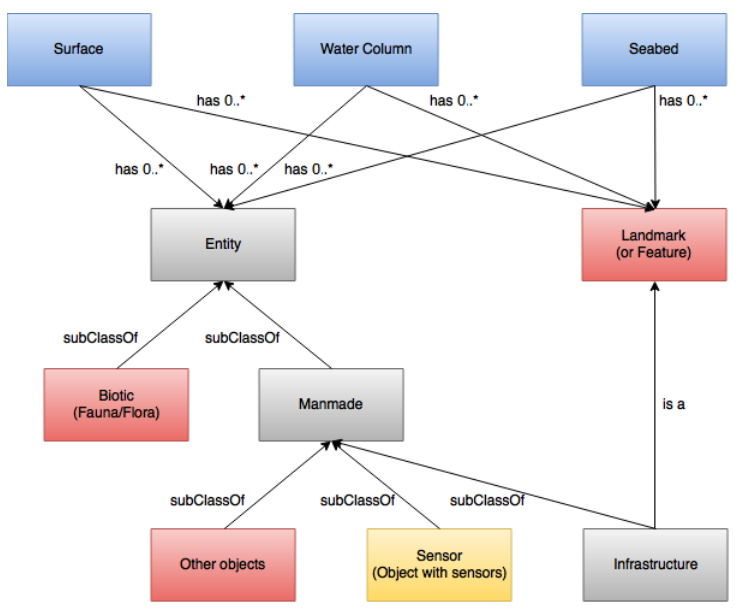
Figure 6. The environment recognition and sensing ontology.